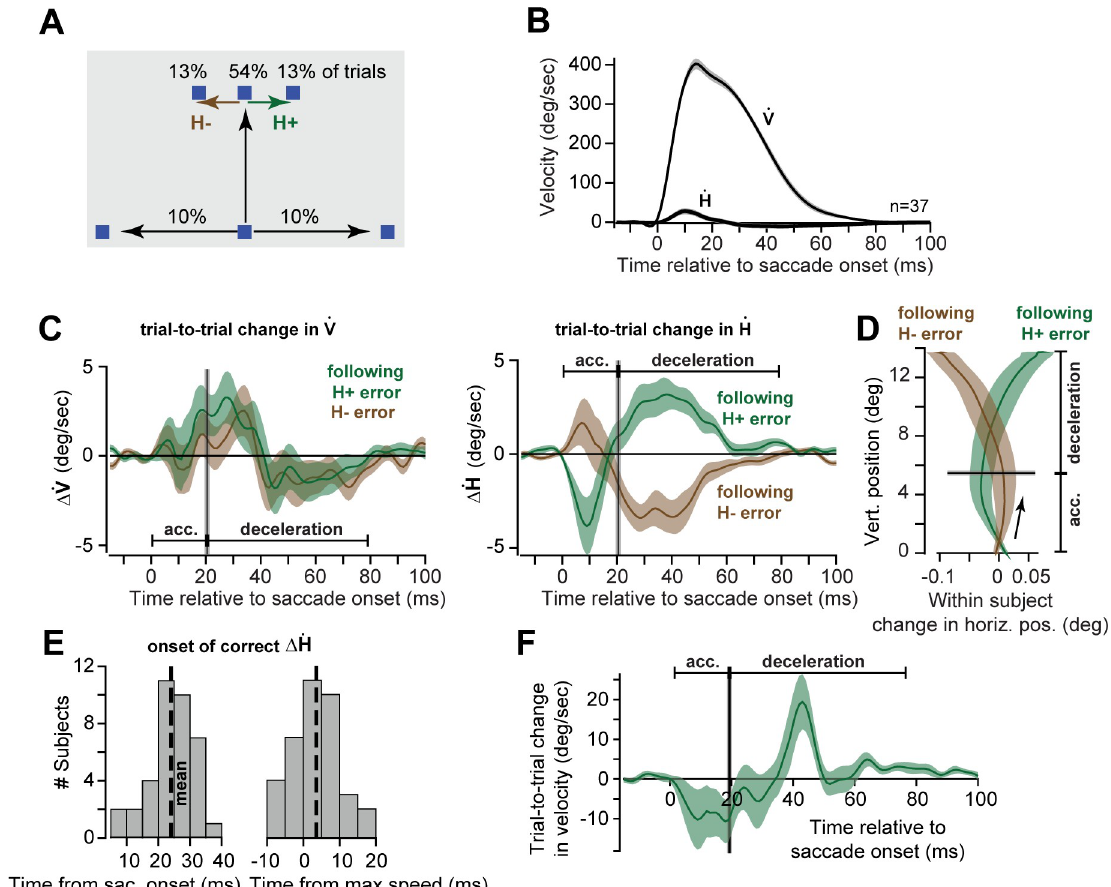
Fig 5. Experiment 3. Following experience of a single error, correction of the subsequent saccade was primarily during deceleration. A . Subjects made vertical saccades and occasionally experienced a horizontal error. B . Average horizontal and vertical velocity of the saccade for the target along the vertical axis. C . Trial-to-trial change in vertical and horizontal velocity following experience of a positive or negative horizontal endpoint error. Vertical line indicates time of peak speed, thus separating the acceleration and deceleration periods. D . Trial-to- trial change in saccade trajectory following experience of a positive or negative horizontal endpoint error. The endpoint correction was primarily due to commands in the deceleration period. Note the large difference in the scales of the x and y axes. E . Onset time of correction in the horizontal velocity following experience of a horizontal endpoint error. Mean onset time is about 3 ms following start of the deceleration period. F . Data from Experiments 1 and 2, measuring the response following the experience of error on the very first trial (velocity on trial 2 minus trial 1, in the direction of the perturbation). Shaded error regions are between subject